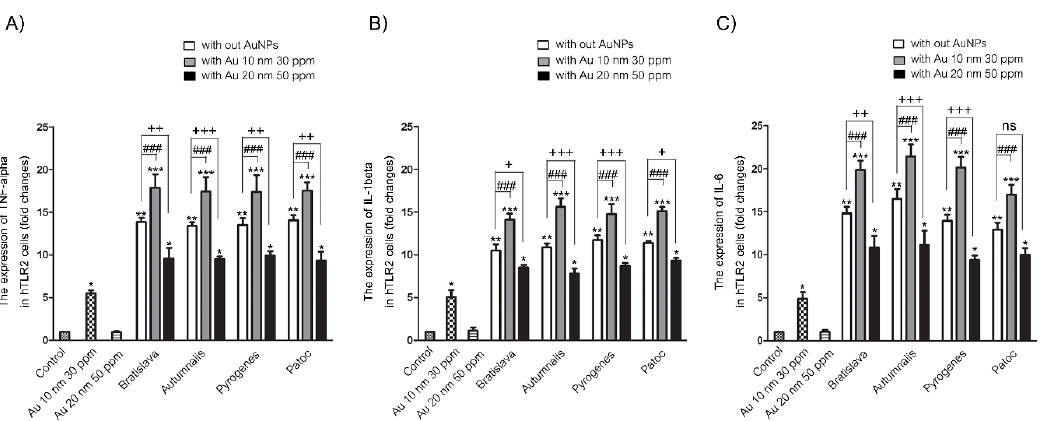
Figure 7. Effect of AuNPs and/or Leptospira serovars on the mRNA expression level of the proinflammatory cytokines ( A ) TNF-α, ( B ) IL-1β and ( C ) IL-6 in HEK-Blue-hTLR2 cells after 24 h treatment, as determined by two-stage qrt-RT-PCR and normalized to the GADPH housekeeping gene expression level. Data are shown as the mean ± SD ( n = 6). Significance of the difference compared to the control group is shown as *, ** and *** for p < 0.05, p < 0.01 and p < 0.001, respectively.